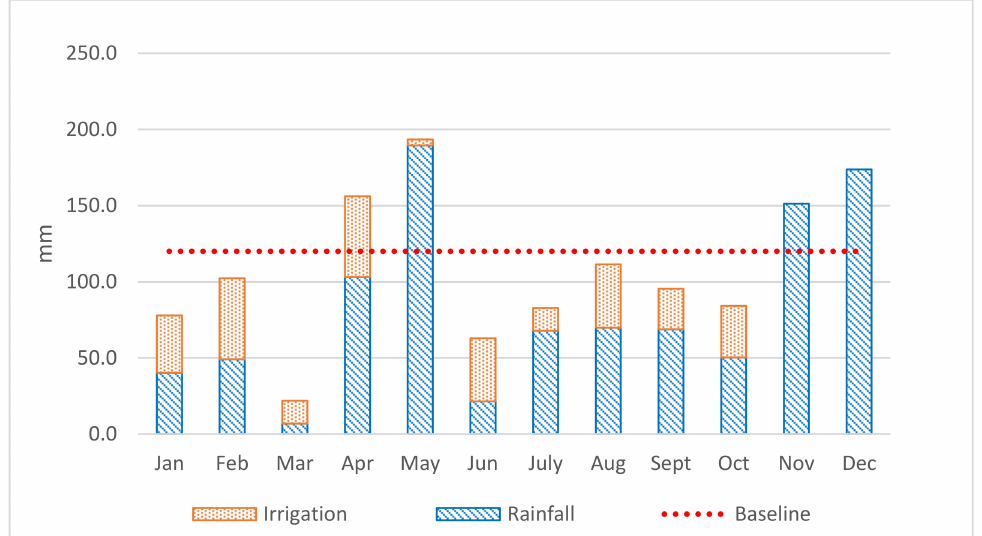
Figure 3. Monthly EID and rainfall distribution for FGVAS Serting Hilir Estate for